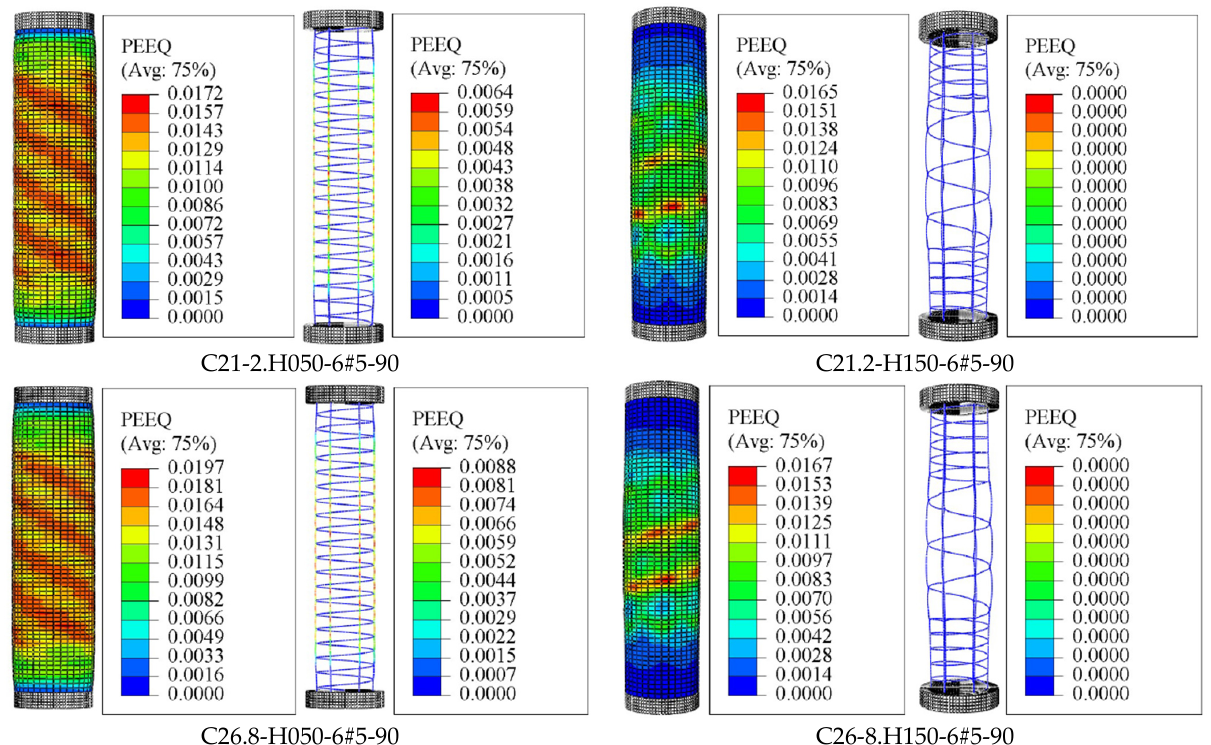
Figure 10. Finite element (FE) failure patterns: Considering the effect of varying amounts of GFRP confinement. Note: PEEQ = Equivalent plastic strain.